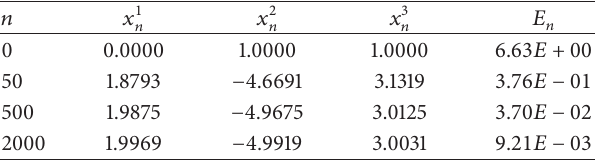
Table 1: Numerical results as regards Example 10